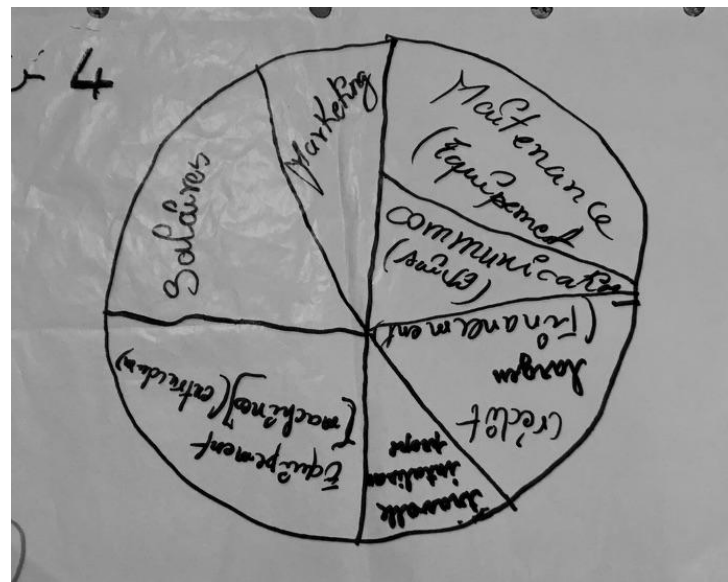
Figure 10. Example from Pie Chart Activity with